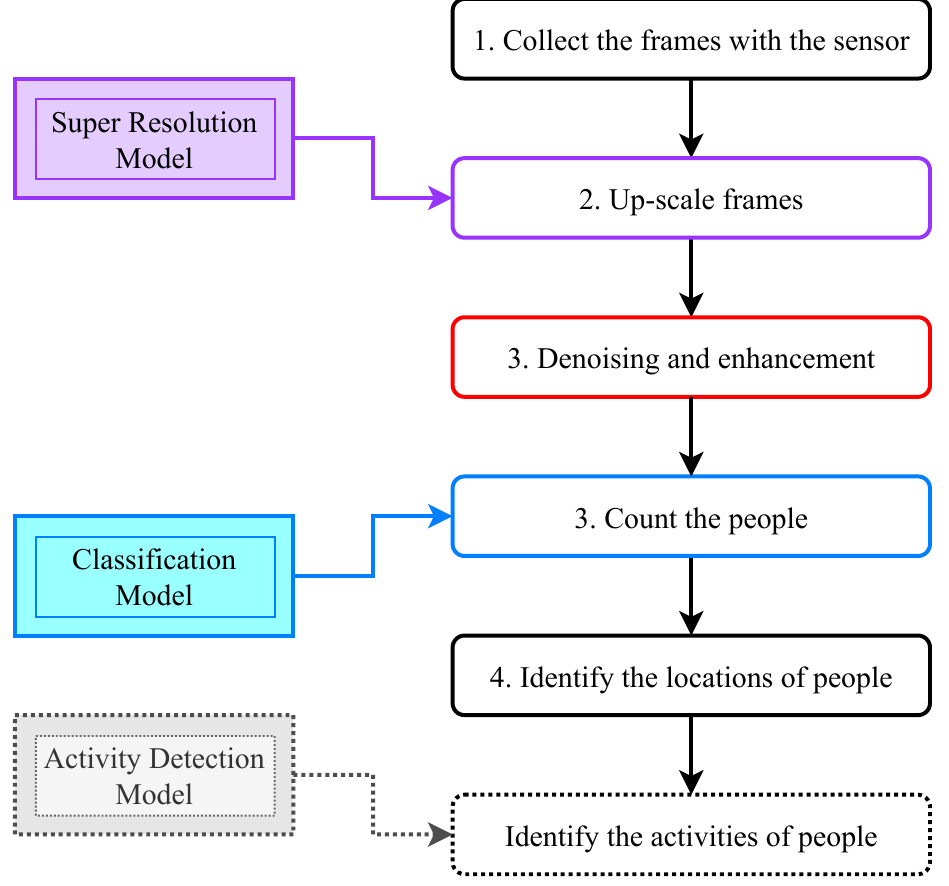
Figure 5. A flowchart of the proposed